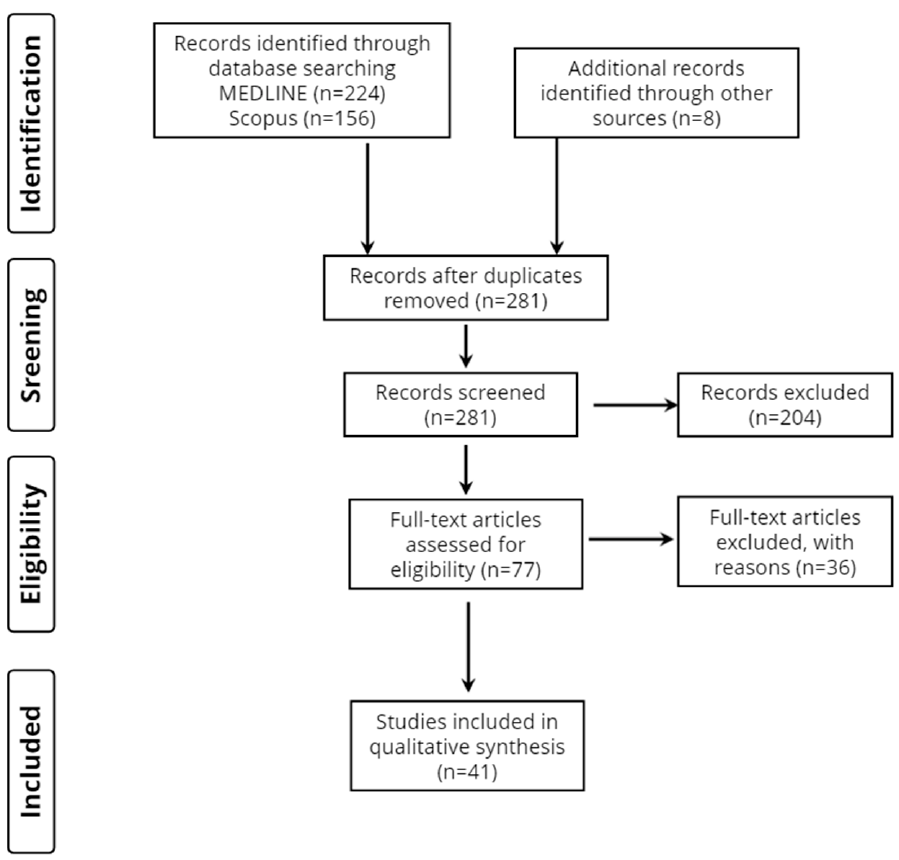
Figure 1. Study flow diagram (PRISMA flowchart).